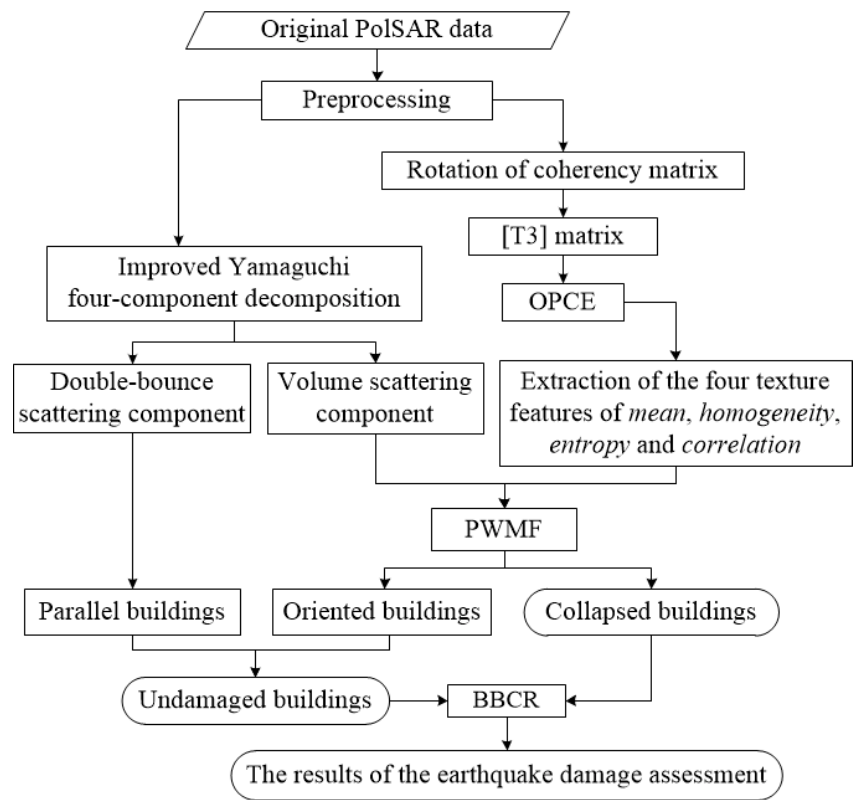
Figure 8. The process flow diagram of the building damage assessment.